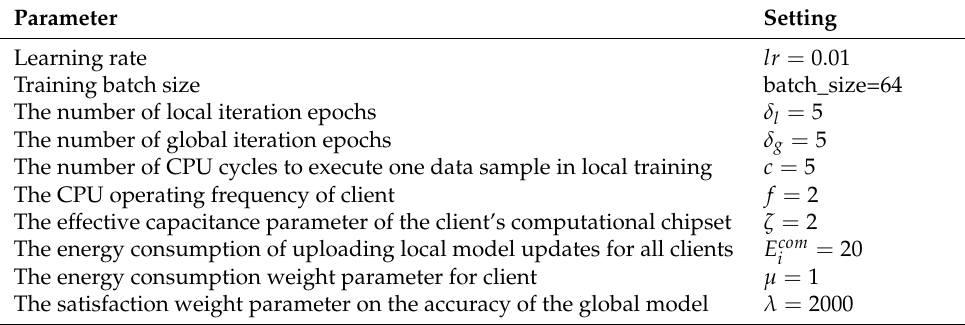
Table 2. Parameter settings in the experimental simulation.